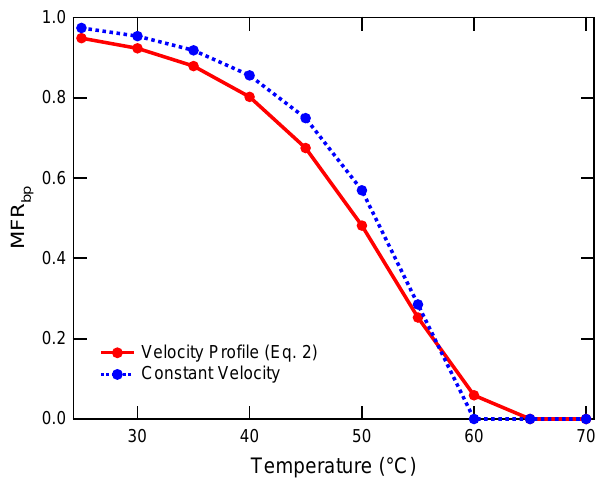
Fig. 3. The mass fraction remaining (referenced to the bypass, i.e. MFR bp ) is shown as a function of T d using the adsorbent denuder boundary condition (Case 1). The solid red curve shows when the laminar flow velocity profile in the thermodenuder is explicitly con- sidered and the dotted blue curve when a flat velocity profile is as- sumed. The calculations assume a single-component aerosol with d p =200nm, C sat =5µg/m 3 , 1H vap =100kJ/mol, C OA =100µg/m 3 , γ e =1, and t res